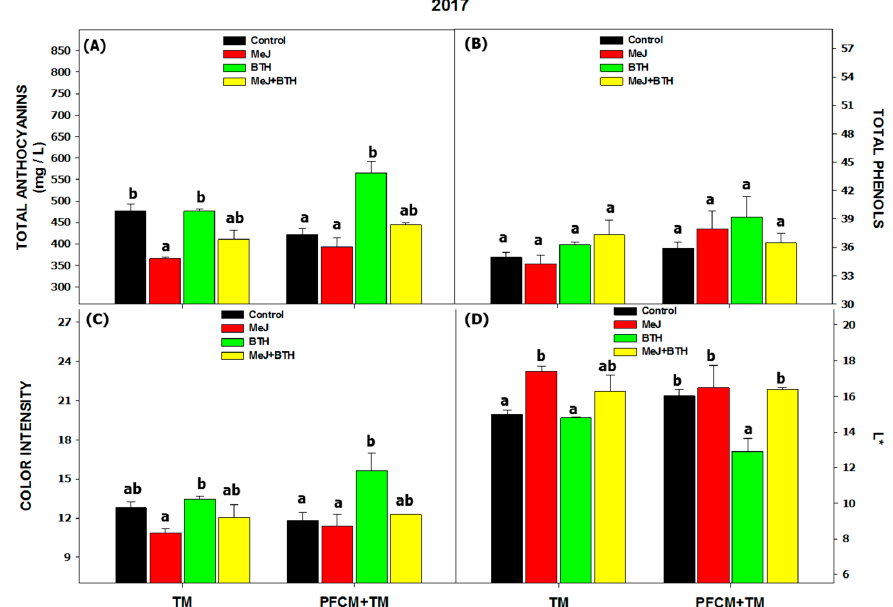
Figure 3. Wine chromatic characteristics in 2017. Total Anthocyanins ( A ), Total Phenols ( B ), Color intensity ( C ), and Luminosity (L*) ( D ). Di ff erent letters within the same oenological technique (TM or PFCM + TM) indicate significant di ff erences according to the Duncan test ( p < 0.05). Abbreviations: MEJ: methyl jasmonate; BTH: benzothiadiazole; TM: traditional maceration; PFCM: pre-fermentative cold